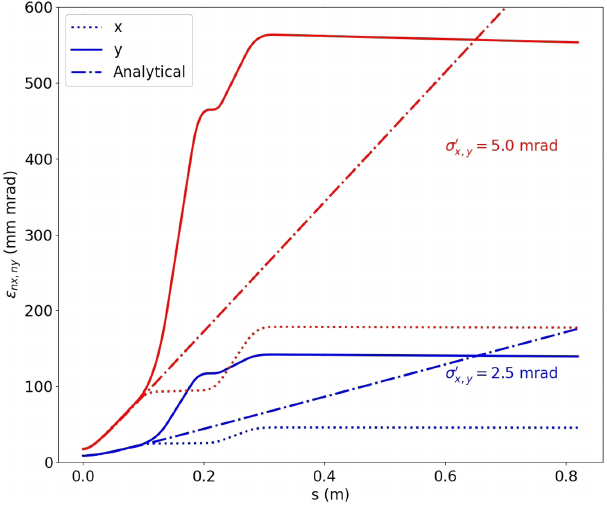
FIG. 11. Transverse beam size over distance with a solenoid for different beam divergences. Due to symmetry, only the beam size in x is shown and exactly the same results apply to y